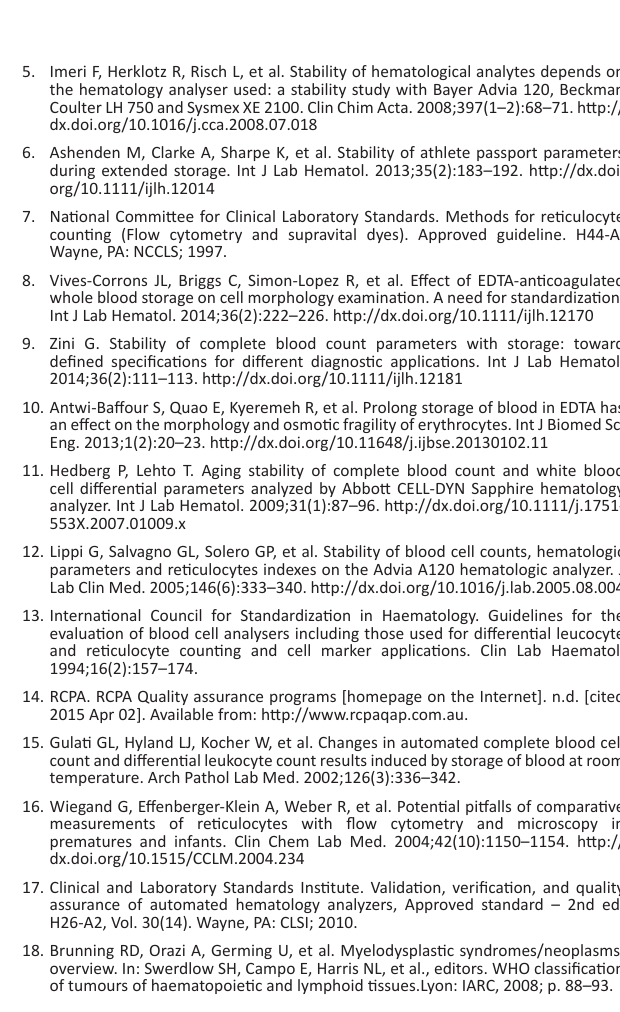
The mean percentage difference for full blood count, differential count and reticulocyte count was plotted against time in hours from the value at time zero. The number of specimens at 24, 96, 120, 144 and 168 hours after collection were 38, 35, 34, 34 and 27, respectively, owing to insufficient sample for analysis or partial aspiration failure. The stability of a parameter was defined in relation to the precision of the ADVIA® 120 analytical method. A parameter was considered stable when its difference was smaller than one coefficient of variation ( % ) of the assessed method. The red diamond indicates the maximum time point at which specimens were stable. FIGURE 2 (Continues...): Stability analysis (mean percent difference) at 4 °C – 8